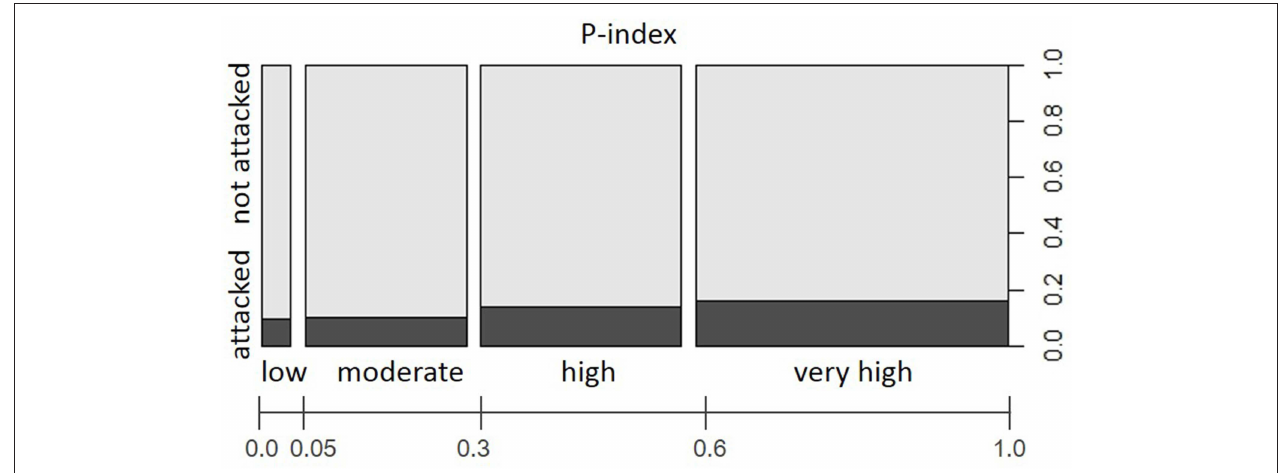
FIGURE 4 | Proportions of forest stands with/without salvage loggings due to I. typographus attacks in the period 2015–2016 within P-index categories “low,” “moderate,” “high,” and “very high” with regard to total study area (i.e., all examined Austrian Federal Forests (ÖBf) forest enterprises). The width of bars along the x-axis represents the relative share of predisposition index classes among examined forest stands.